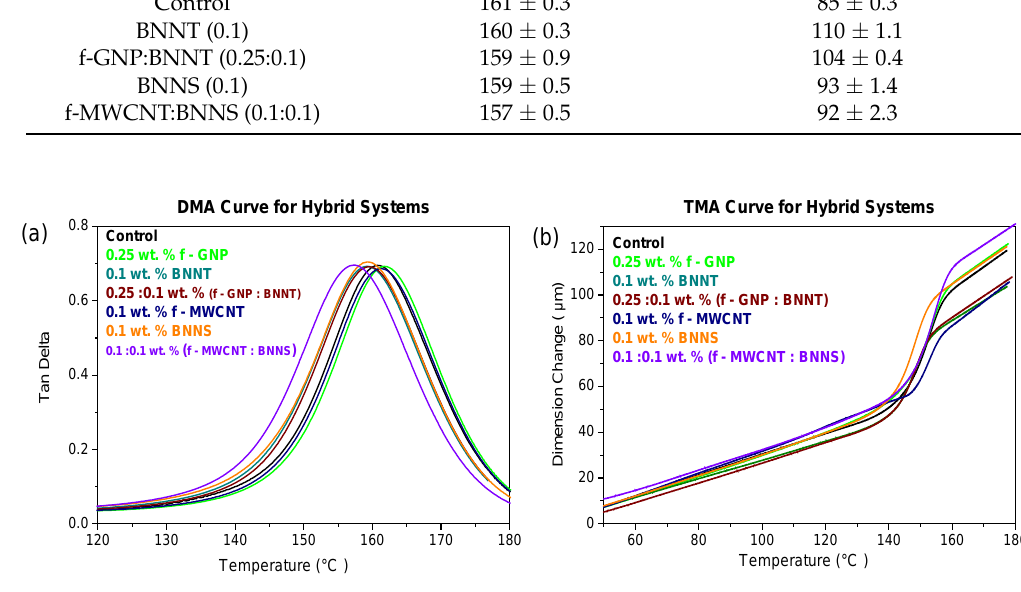
Figure 9. Damping behaviour ( a ) tan δ of hybrid systems and ( b ) TMA curve of hybrid systems.